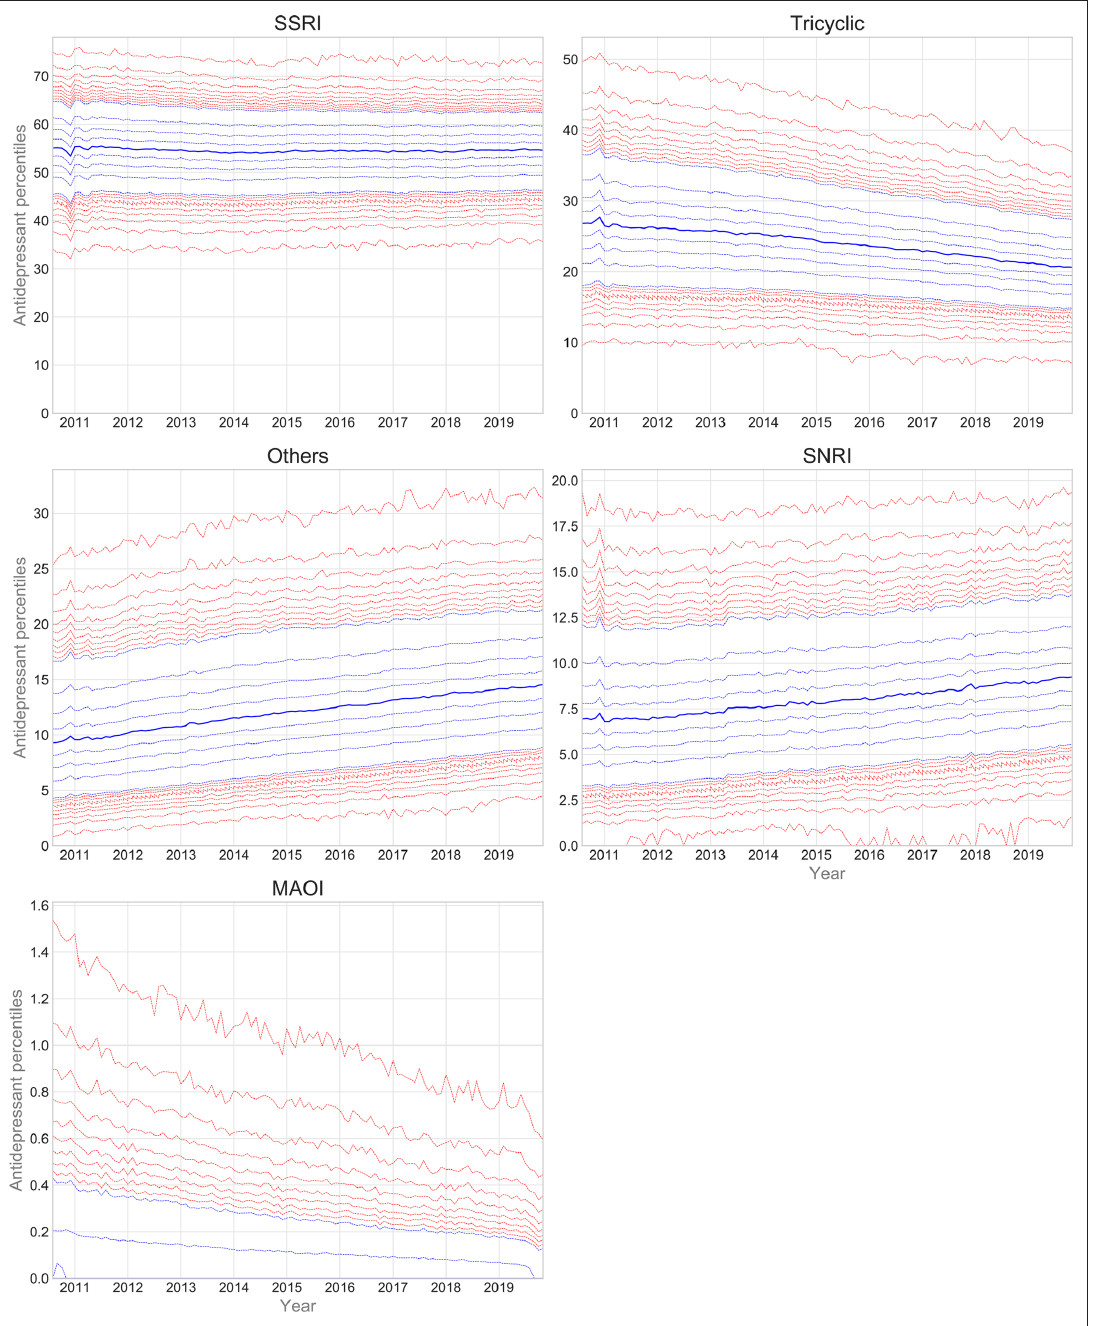
Figure 4 Practice- level percentile charts for the proportion of antidepressant items in each class, from August 2010–November 2019. Deciles are in blue, with median shown as a heavy blue line, and extreme percentiles in red. MAOI = monoamine oxidase inhibitor. SNRI = serotonin- norepinephrine reuptake inhibitor. SSRI = selective- serotonin reuptake